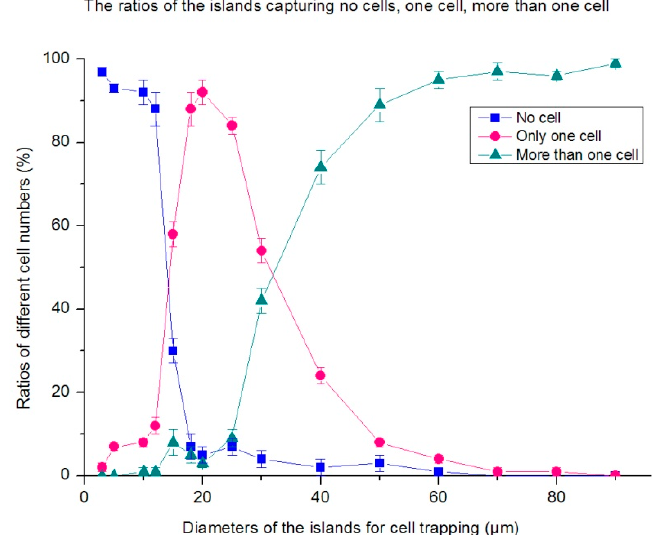
Figure 10. The ratios of patterning islands capturing no cells, only one cell, two, or more than two cells. It is indicated that the islands with diameters between 15–25 µ m are the optimal ones to capture only one cell, and are favorable for forming a single-cell patterning chips.